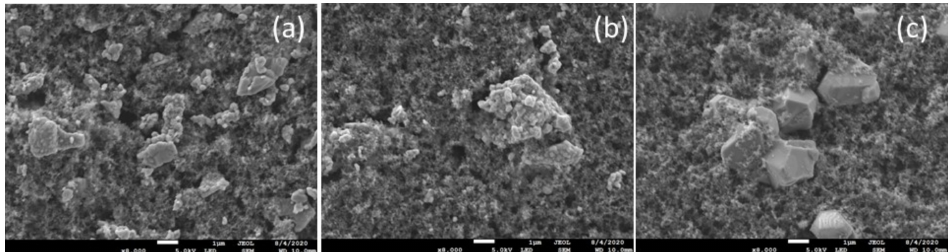
Figure 3. SEM images of spinel powders prepared by EDTA-assisted sol-gel method. ( a ) LiMn 2 O 4